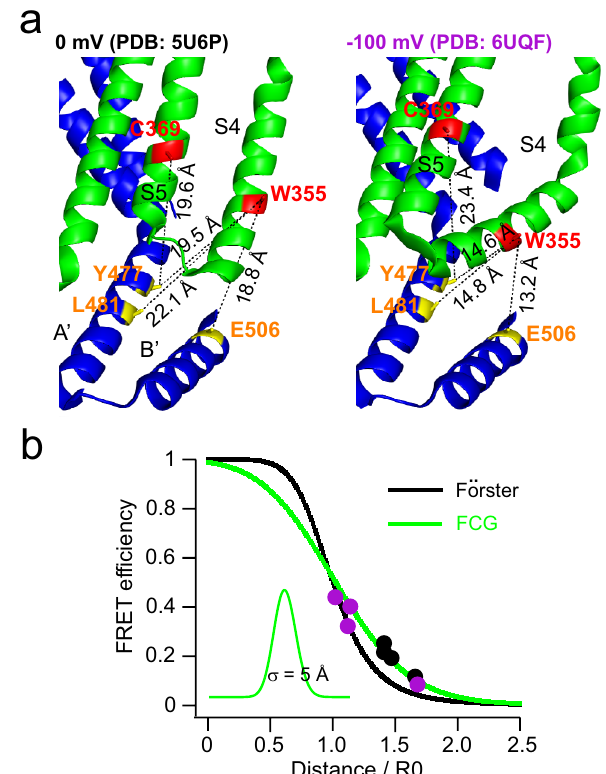
Fig. 4 Distance determination using measured FRET ef fi ciencies, guided by FCG and homologous structures. a Eight FRET pairs used to obtain the Förster Convolved with Gaussian (FCG) relation to determine the distance dependence of the FRET ef fi ciency. The C β – C β distances were measured from the homology models based on human HCN1 (PDB:5U6P and PDB: 6UQF) assuming they correspond to the structures at 0 and − 100mV respectively (in the presence of cAMP). b The measured FRET ef fi ciencies are plotted versus the distances measure in panel a (in R 0 units) as 4 black (0mV) and 4 purple ( − 100mV) circles. Predicted distance dependencies of the Förster equation (black) and the FCG relation (green) are shown. The FCG relation used a Gaussian distribution with a standard deviation, σ , of 5Å